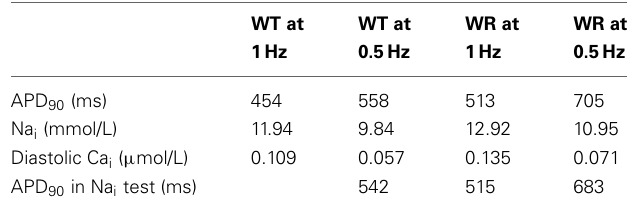
Table 3 | Effect of bradycardia on APD 90 , Na i , and diastolic Ca i at steady